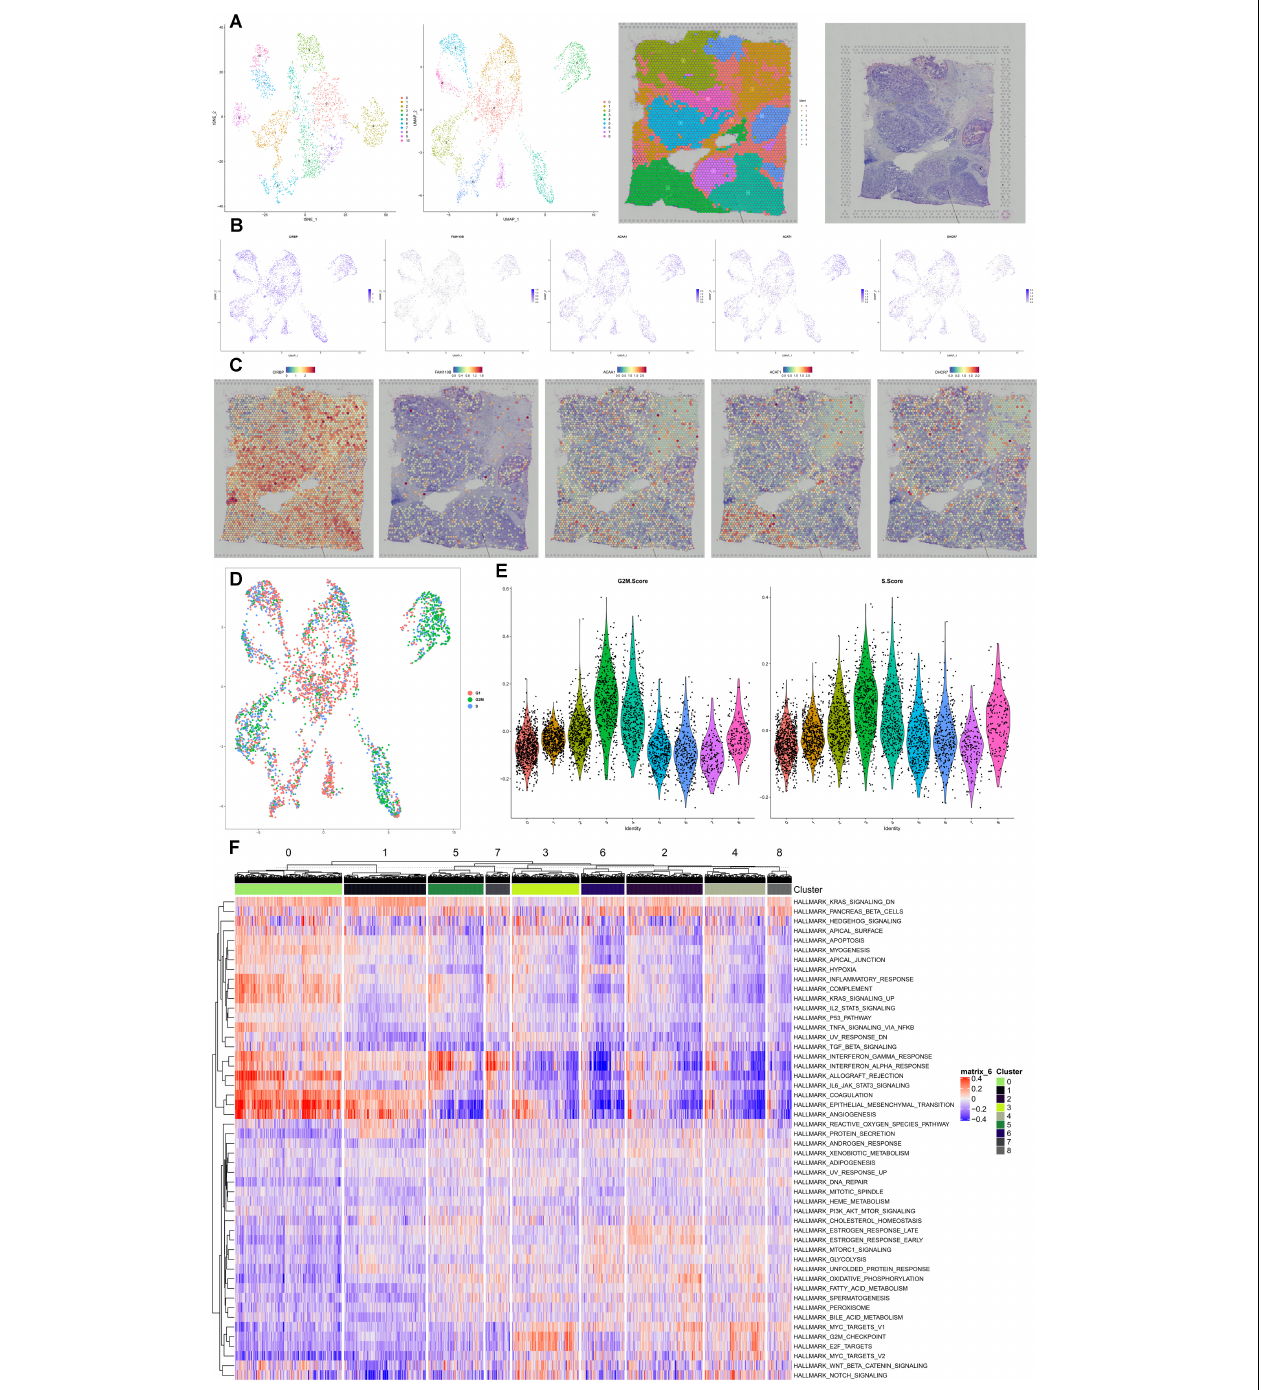
FIGURE 9 | Spatial transcriptome validation. Spatial transcriptome combined with scRNA-seq data of BRCA was used to identify the cell subtype localization of the key genes in the speculative regulatory mechanism. Eleven clusters and nine clusters were identified by t-SNE and UMAP (A) . Invasive ductal carcinoma and intraductal carcinoma in situ as well as normal tissue were clearly demonstrated in HE staining slides (A) . The feature plots and spatial feature plots were utilized to illustrate the distribution and expression of CIRBP, FAM110B, ACAA1, ACAT1, and DHCR7, showing that these key genes were highly expressed in the invasive ductal carcinoma tissue (clusters 2, 5, 8) (B,C) . Additionally, the cell-cycle analysis suggested that most cells highly expressing these key genes were in the phase of G2M and S (D,E) , and those cell-division-related signaling pathways such as HALLMARK_G2M_CHECKPOINT and HALLMARK_E2F_TARGETS were activated while some tumor-suppressor signaling pathways such as HALLMARK_P53_PATHWAY and HALLMARK_TNFA_SIGNALING_VIA_NFKB were downregulated in the invasive ductal carcinoma tissue (F) .